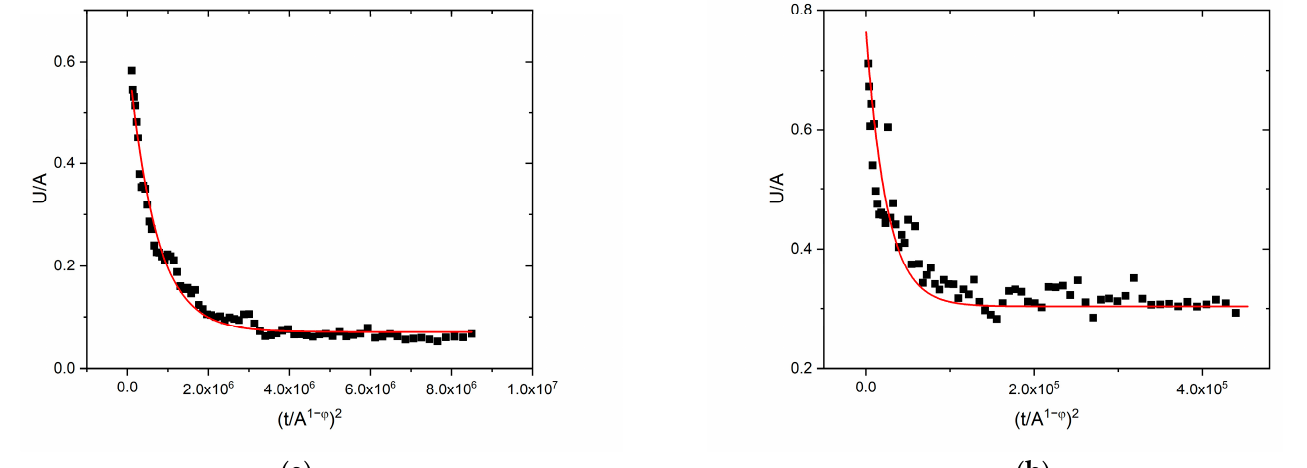
Figure 3. Fitting of the exponentially decaying tail of ( a ): curve 4 of Figure 1b (9 × 10 − 6 Vs–2 × 10 − 5 Vs) and ( b ): curve 5 of Figure 13 in [23] (7.5 × 10 − 6 Vs–8.5 × 10 − 5 Vs), according to Equation (2).